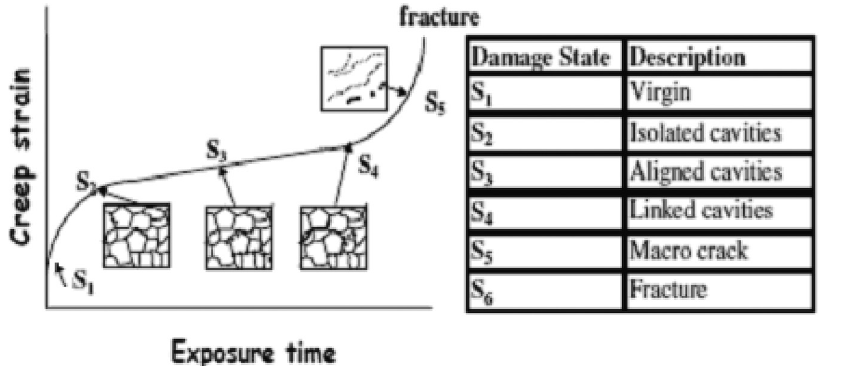
Figure 8: A schematic representation of the nature of damage evolution in material subjected to creep loading and the phases used to represent the same.